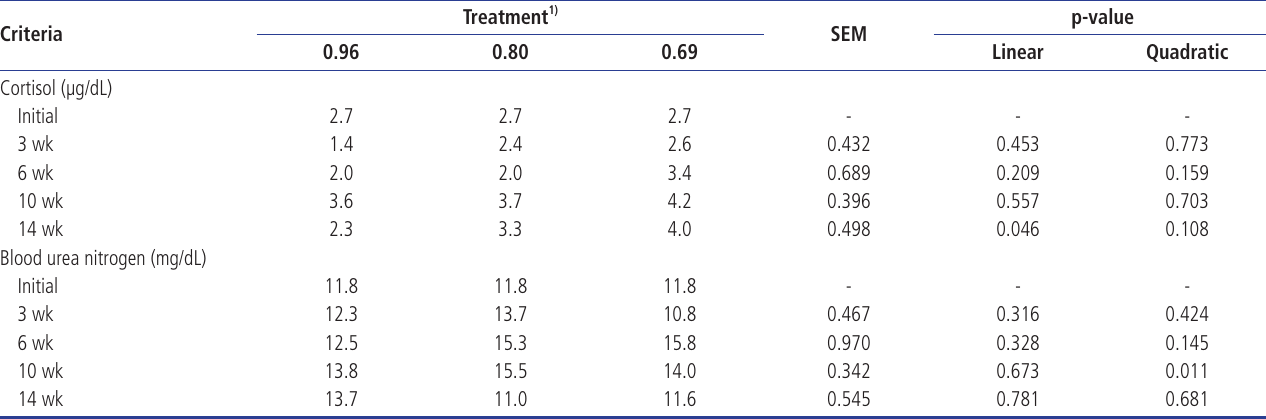
Table 3. Effect of different space allowance on serum cortisol and BUN concentration Criteria